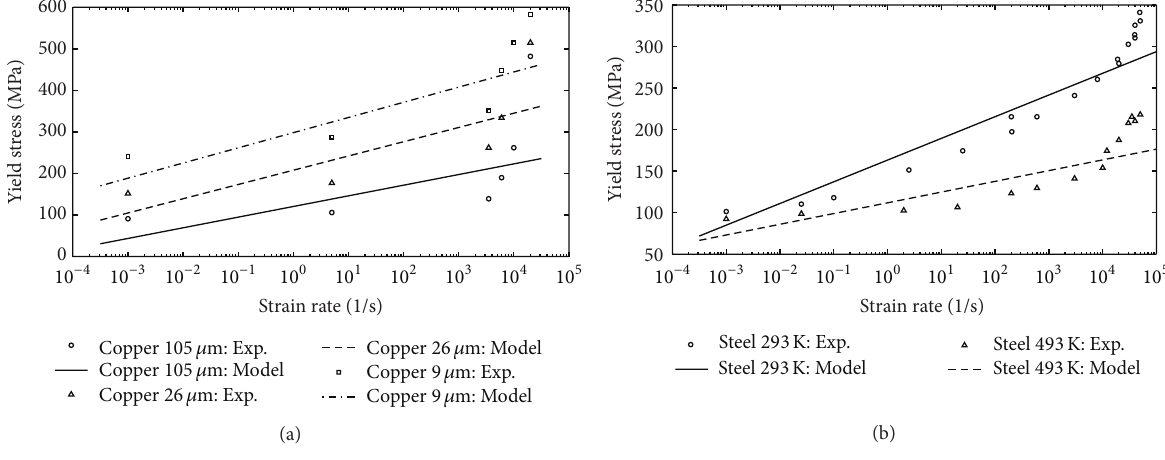
Figure 1: Yield stress fitting by the standard Johnson-Cook model: (a) copper and (b) steel.